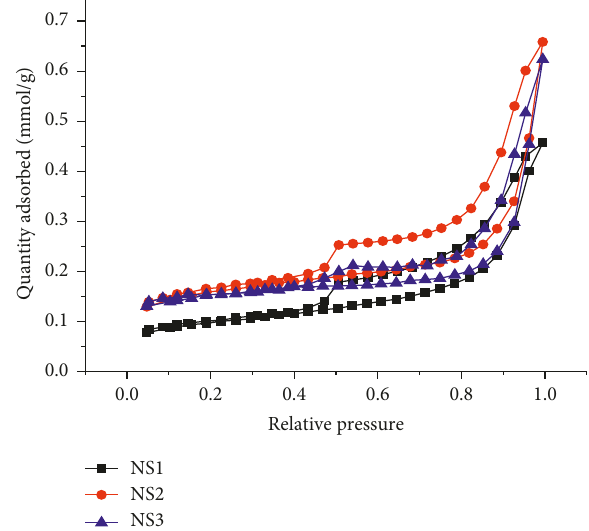
Figure 4: Isotherm sorption of hardened cement paste by nitrogen adsorption.